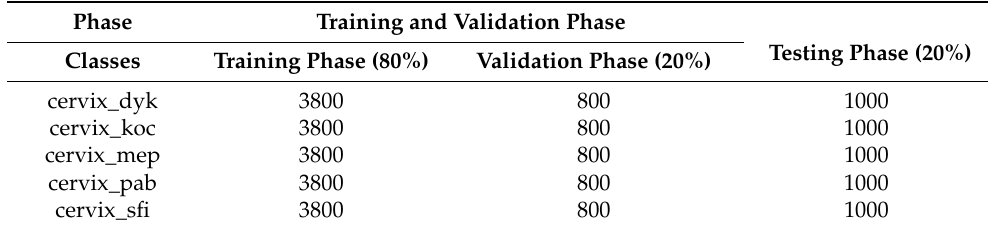
Table 1. Division of the data set of abnormal cells of cervical cancer. Phase Training and Validation Phase